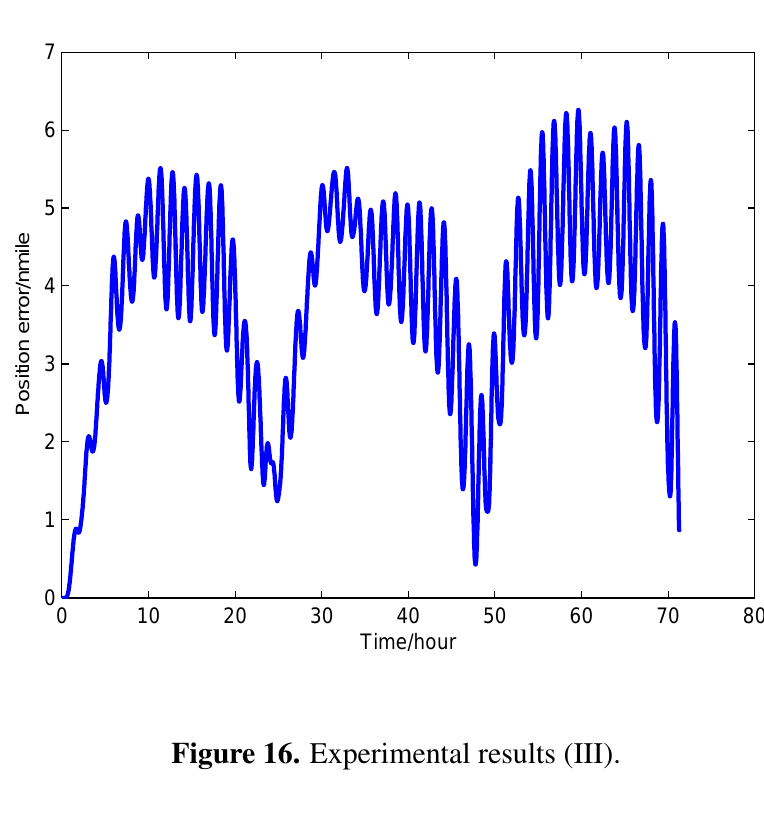
Figure 15. Experimental results (II).